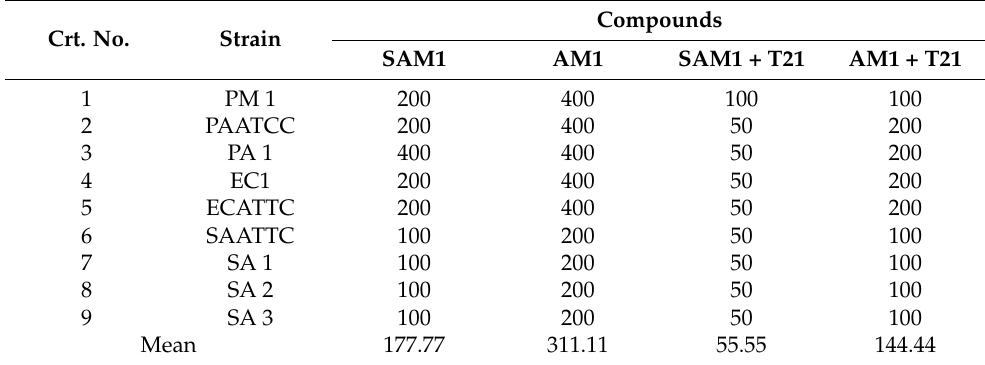
Table 2. MIC for SAM1, AM1, and their combinations with T21 (mean µ g/mL). Crt.